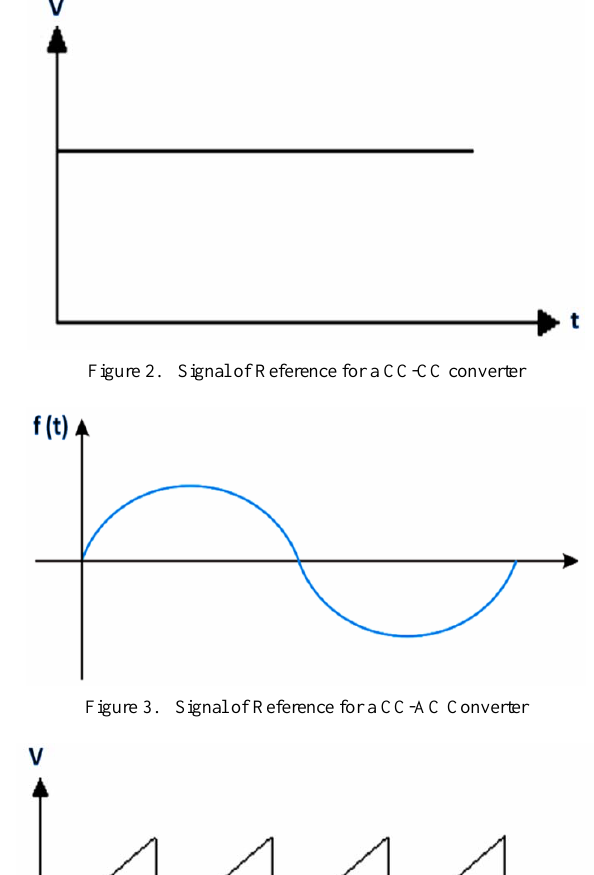
Figure 4. Sawtooth wave